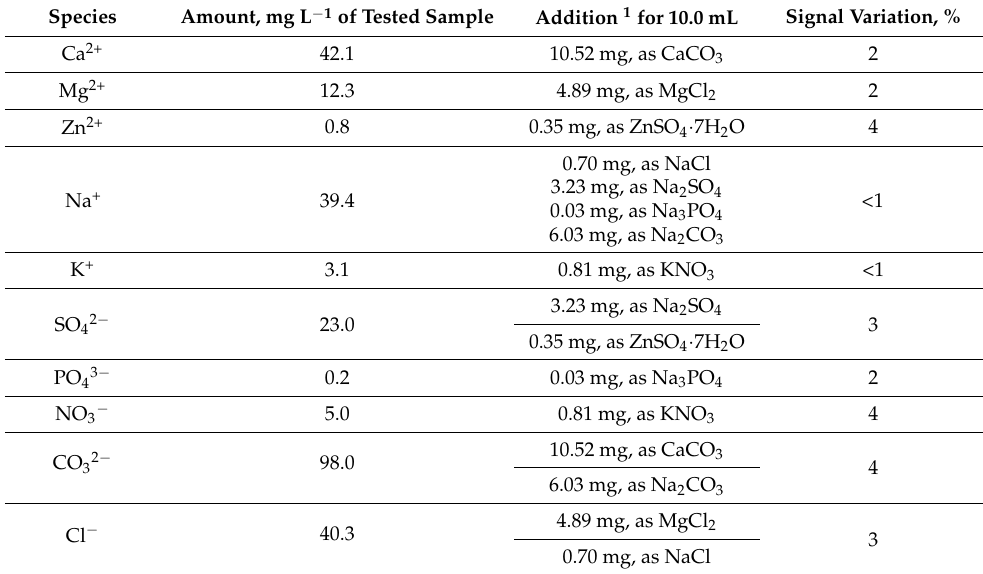
Table 10. Inorganic species detected in the tested sample of tap water and their effect on the deter ‐ mination of herbicide in a solution of these ions with a 10 ‐ fold higher concentration.